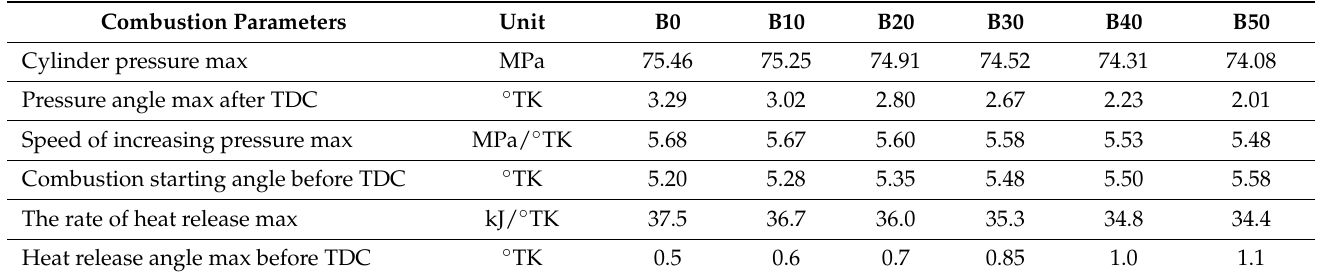
Figure 7. Variation of heat release rate values with respect to crank angle.